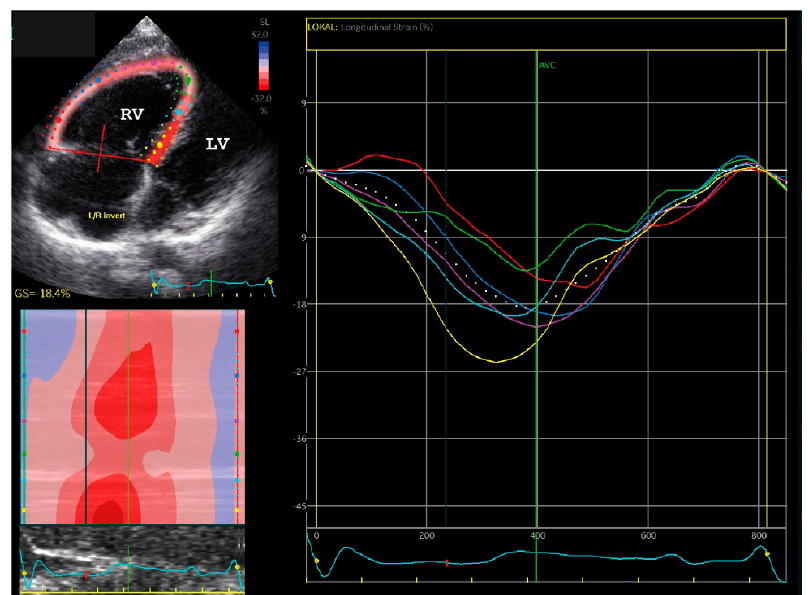
Figure 3. Speckle tracking echocardiography (STE) demonstrated dyssynchrony of the septal and right ventricular free-wall segments (see also Video 1, Supplementary Data).